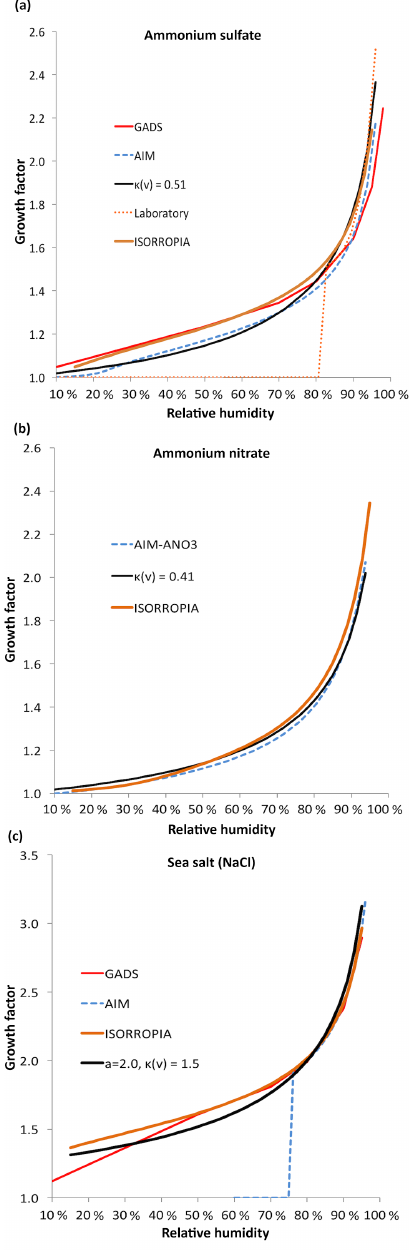
Figure 1. Hygroscopic growth factors for ammonium sulfate (top), ammonium nitrate (centre), and sea salt (bottom). GADS = Global Aerosol Data Set estimated from empirical data (Koepke et al., 1997). ISORROPIA indicates aerosol thermodynamic model at T = 298K (reverse mode) and assuming linear water/solvent vol- ume additivity (Fountoukis and Nenes, 2007). AIM = Aerosol In- organic Model calculated metastable growth for ammonium sulfate and ammonium nitrate at T = 298K (Wexler and Clegg, 2002). Laboratory ammonium sulfate fit is GF = 149 + 281 · RH 24 . 6 (with deliquescence at 80%) for bulk pure ammonium sulfate (Wise et al., 2003). All components are fit using Eq.